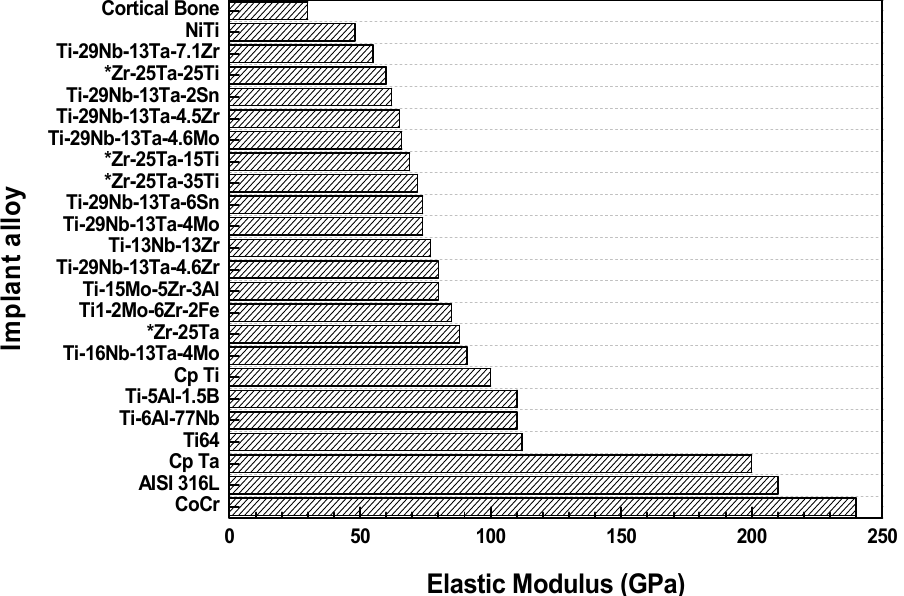
Figure 7. Young’s modulus of Zr-25Ta-xTi alloys analyzed in this paper, compared with commercial metals used as biomaterials (reprinted with permission from reference [23]). metals used as biomaterials (reprinted with permission from reference